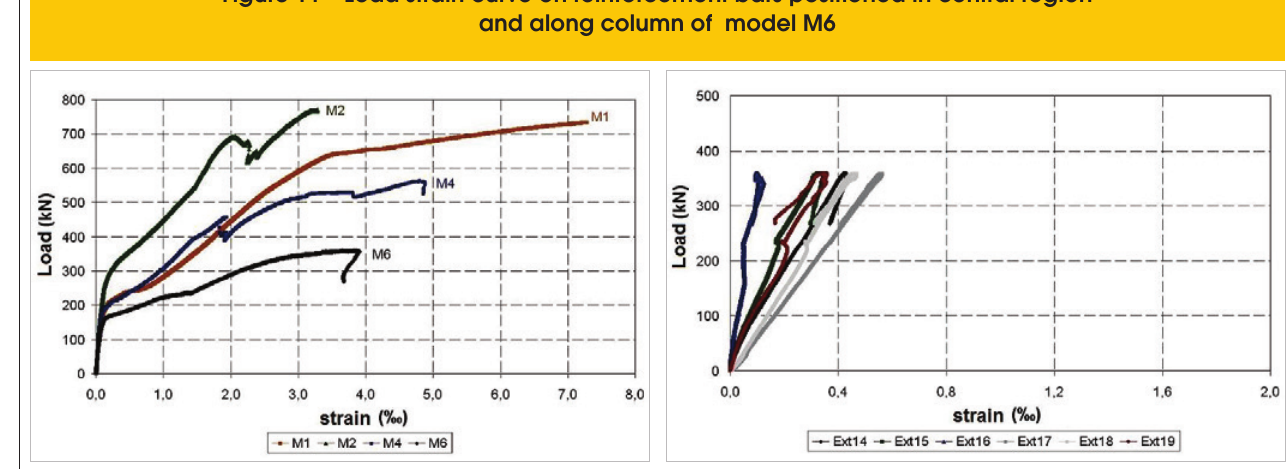
Figure 14 – Load-strain curve on reinforcement bars positioned in central region and along column of model